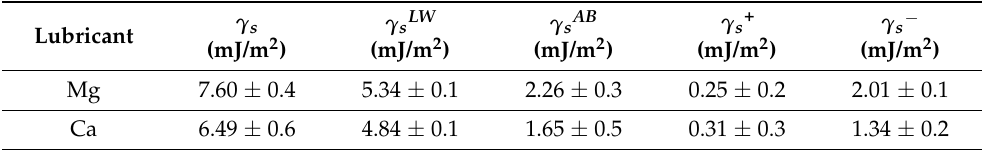
Table 4. Surface free energy( γ s ), Lifshitz-van der Waals force( γ sLW ), Lewis acid-alkali force( γ sAB